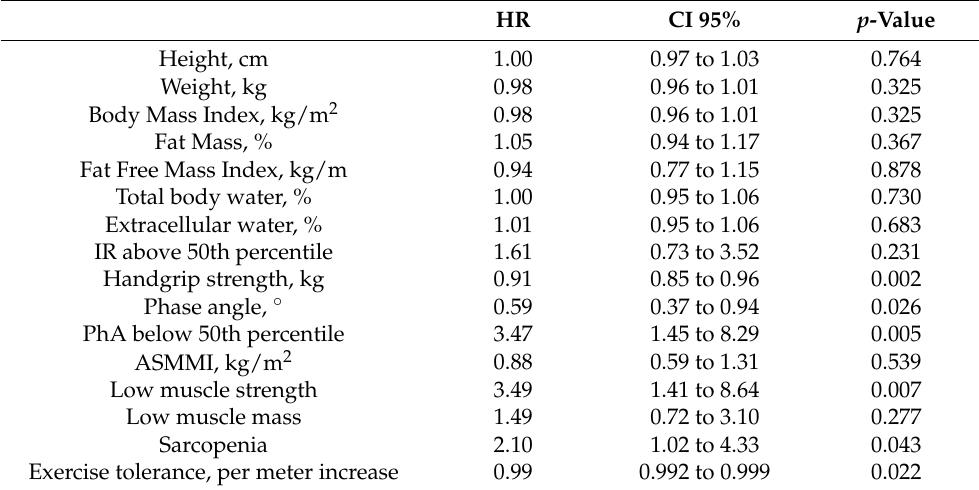
Table 3. Multivariate analysis of body composition predictors of mortality in COPD